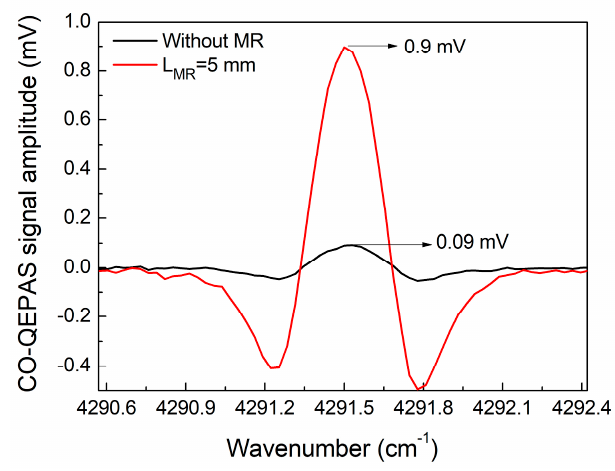
Figure 5. QEPAS signal amplitude without MR and MR with a length (L MR ) = 5 mm.